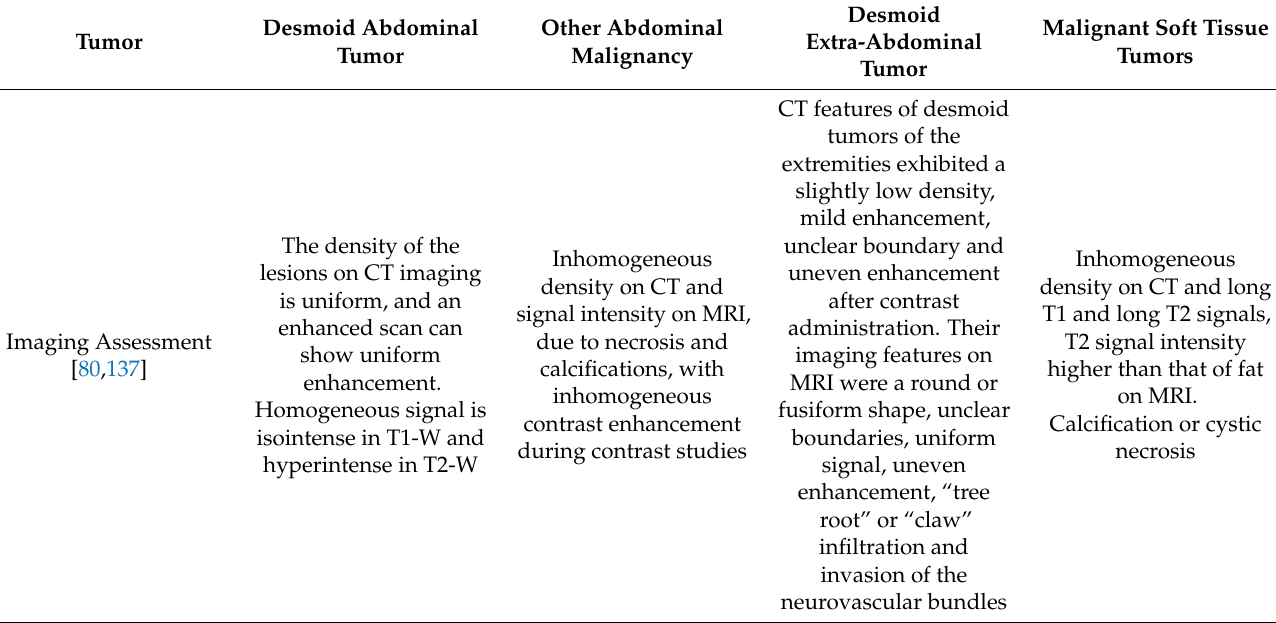
Figure 3. Axial ( a ) and MPR coronal ( b ) CT assessment of aggressive fibromatosis (arrow) in portal phase of contrast study. The lesion shows mild enhancement and involvement of blood vessels. To the best of our knowledge, no one study described the role of DECT in DTs. As in US, CT also plays a pivotal role in guiding ablative treatment. In particular, CT- guided cryoablation is safe, effective and offers some important advantages. First, it pre- sents the possibility of treating even large and multiple lesions in one session, creating a large area of ablation with low risks of spreading the pathological cells. Second, the tech- nique is minimally invasive and requires low hospitalization times and mild anesthesia. Third, the functional recovery is satisfyingly immediate. Fourth, the procedure can be re- peated with no risks for the patient in case of partial treatment [150–152].